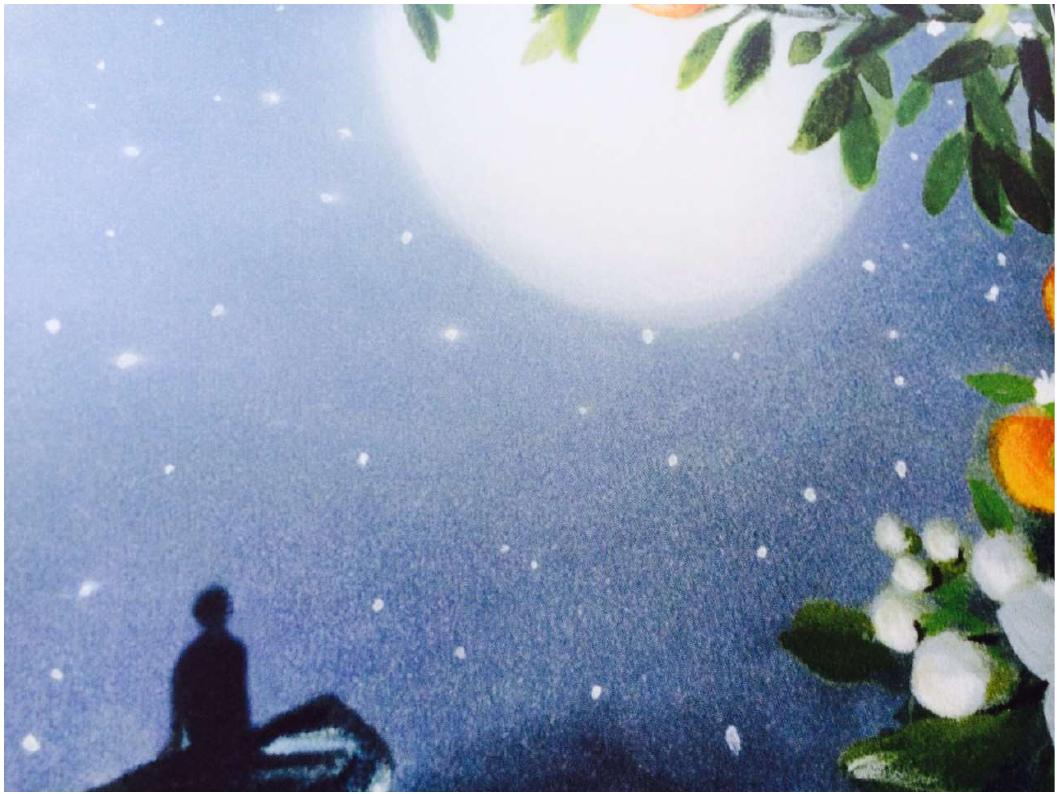
Figure 5. Youssef dived into the sea, by: Il sogno di Youssef , cit. p.